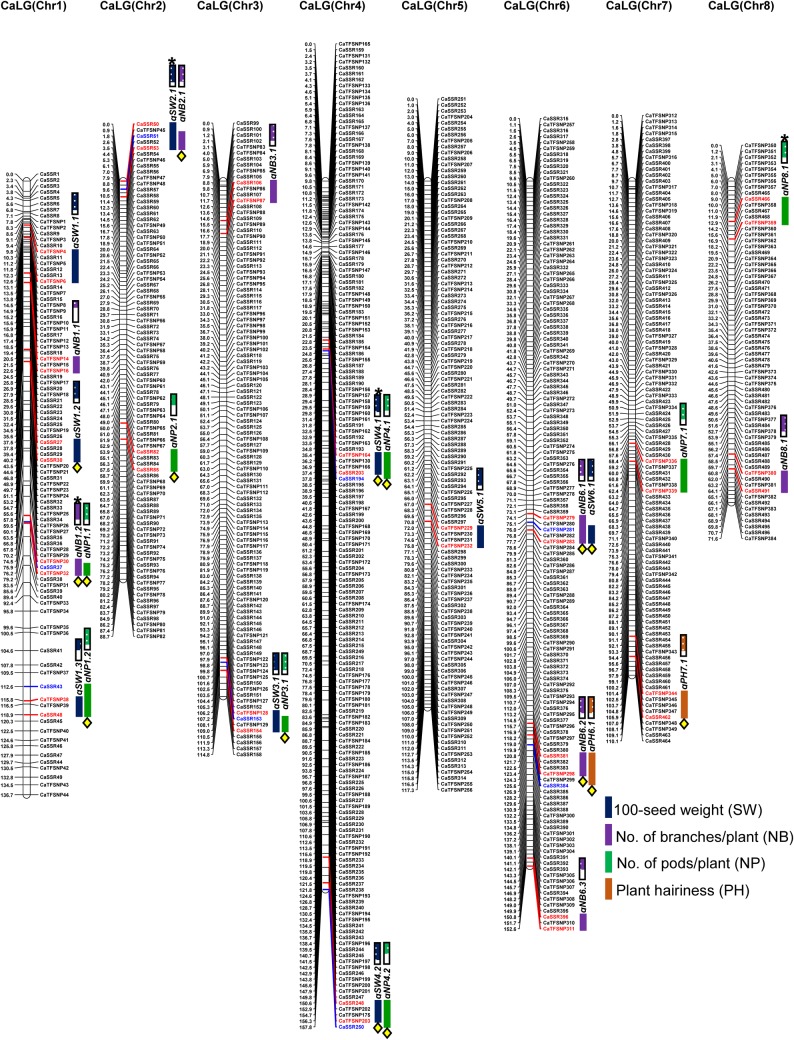
Nineteen genomic regions harbouring 27 significant QTLs (15.6–39.8% R2) associated with SW, NP, NB and PH were identified and mapped on eight LGs (LOD > 4.0 at P < 0.05) using a 229 RIL mapping population (ICC 4958 × ICC 17160) of chickpea. The genetic distance (cM) and identity of the marker loci integrated on the chromosomes are indicated on the left and right sides of the LGs, respectively. The 15 major and robust QTLs are marked with yellow boxes. The marker pairs flanking the QTLs are coloured with red and blue. Blue, violet, green and brown lines indicate the QTLs regulating SW, NB, NP and PH mapped on eight LGs. The direction of QTLs (additive effects) are designated with empty (ICC 17160-specific alleles) vs. filled (ICC 4958-specific alleles) boxes. *qSW2.1, qSW4.1, qNP8.1 and qNB1.2 correspond to known QTLs from previous studies by Cobos et al.,53,54 Hossain et al.,55 Varshney et al.56 and Gowda et al.57 This figure appears in colour in the online version of DNA Research.